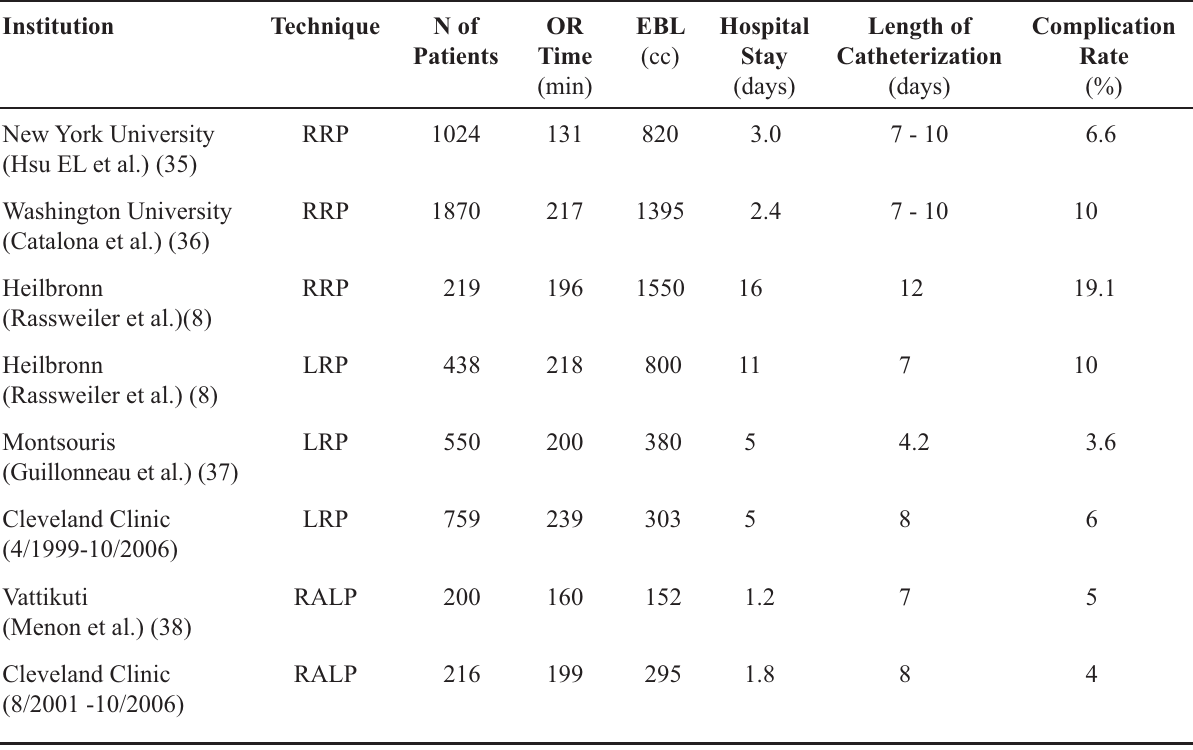
Table 1 – Operative outcomes of RRP, LRP and RALP from select